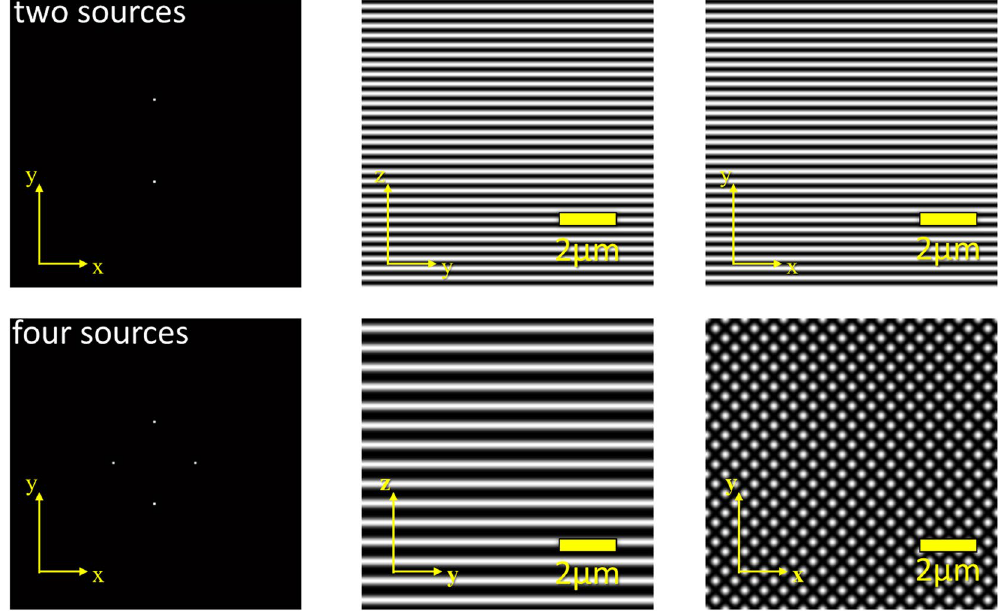
Figure 2. Arrangement of 2 and 4 coherent light sources and resulting focus intensity distribution. Left: z-projection of the arrangement of a few coherent light sources (e.g. glass fibers with low NA) directed towards the origin (refractive index n = 1). The optical axis is defined by the origin and the bary center of all sources. Sources are positioned at an elevation of 45° with respect to the optical axis. Center: y-z section across the intensity distribution around the origin. Right: x–y section across the intensity distribution around the origin.